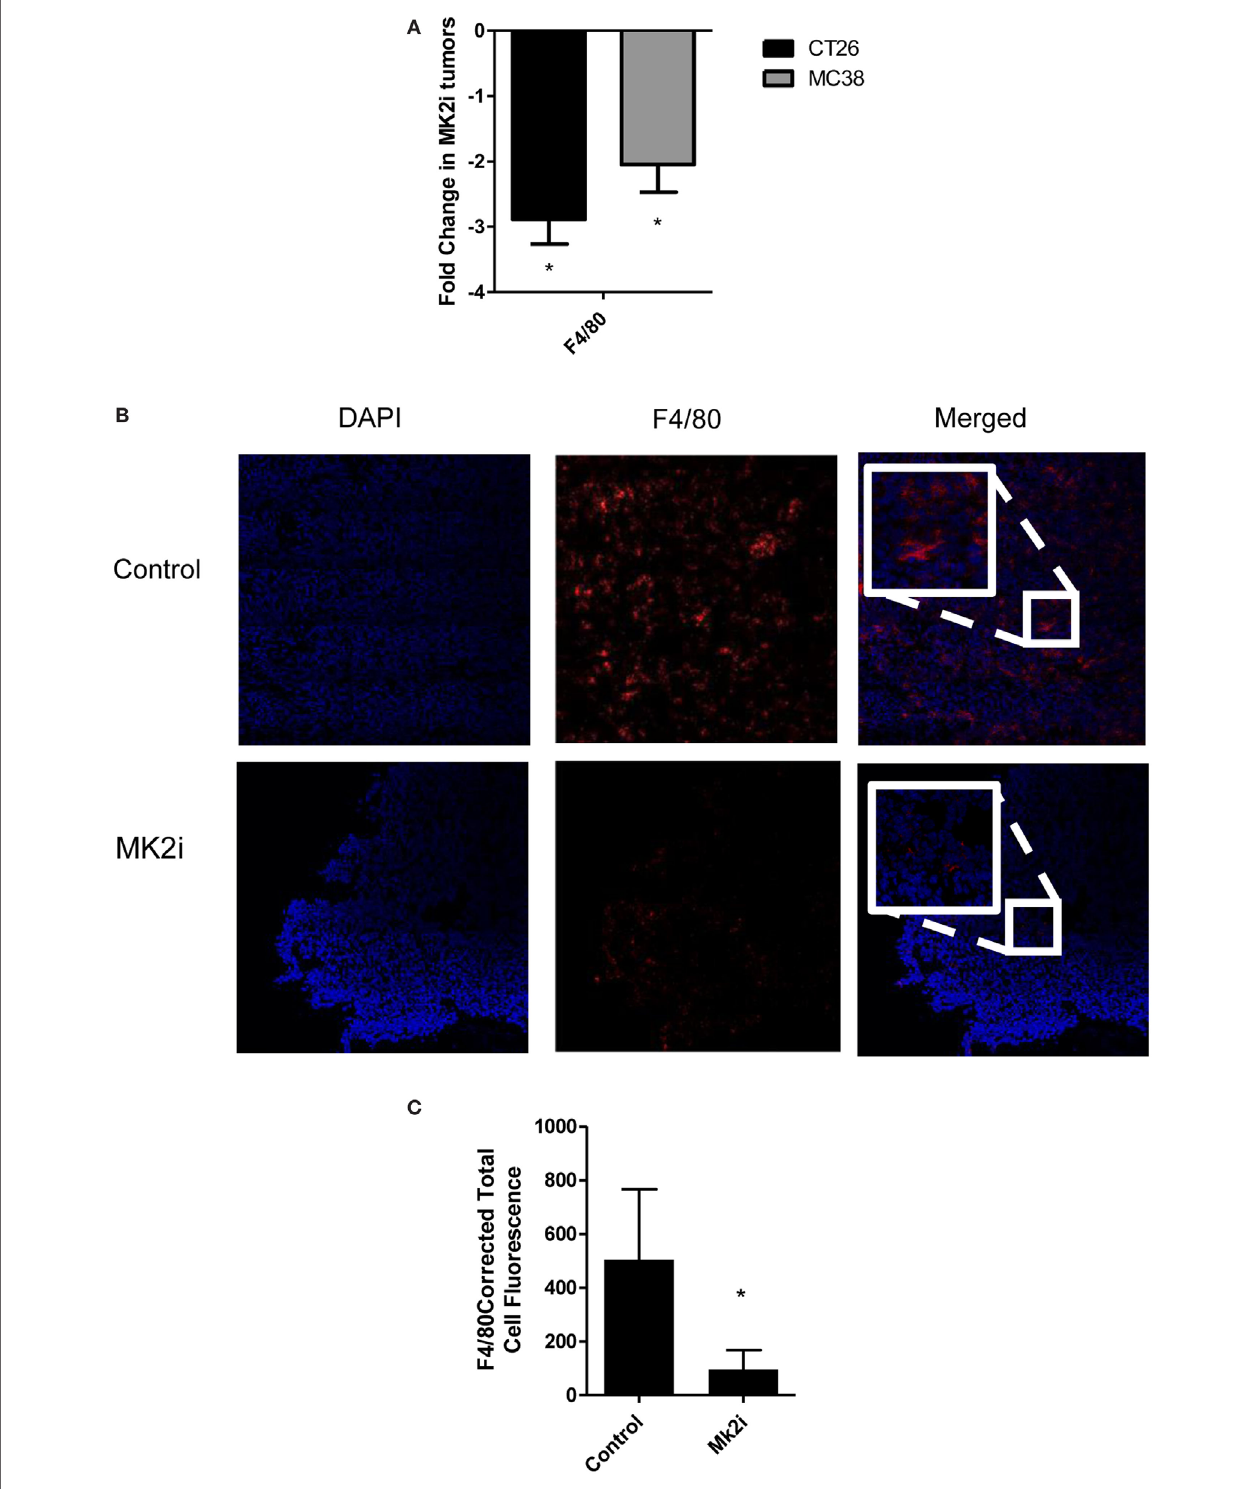
FigUre 4 | Macrophage influx is decreased in tumors treated with MK2 inhibitor. Tumors developed from cells treated with MK2 inhibitors showed decreased macrophage markers at day 13 by (a) mRNA levels of F4/80 and (B) by confocal microscopy of F4/80 staining with example images and (c) combined corrected total cell fluorescence from multiple images where the mean of 10 fields from each image was calculated divided by the mean background fluorescence. The squares show high power resolution view of a randomly selected area in each low power resolution